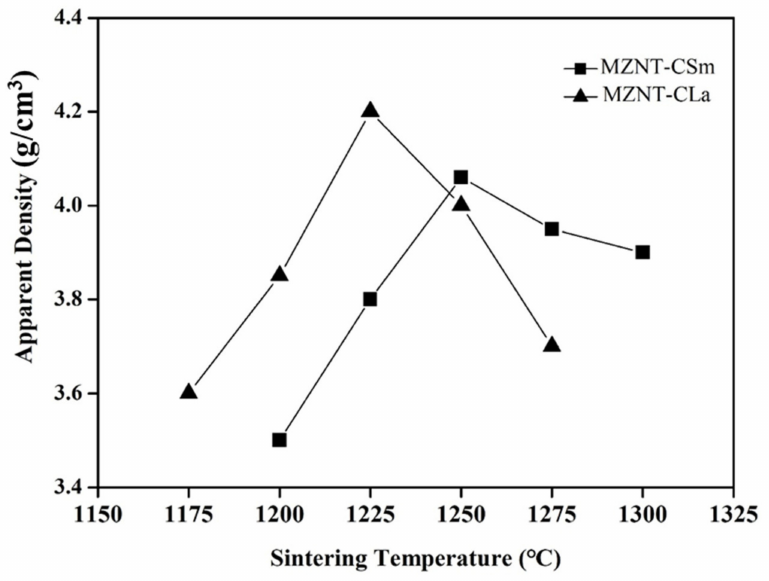
Figure 6. Dependence of apparent density on sintering temperature of the 0.88(Mg 0.6 Zn 0.4 ) 0.95 Ni 0.05 TiO 3 -0.12Ca 0.6 La 0.8/3 TiO 3 /Ca 0.8 Sm 0.4/3 TiO 3 ceramics. Table 1. Microwave dielectric properties of (Mg 0.6 Zn 0.4 ) 0.95 Ni 0.05 TiO 3 with Ca 0.6 La 0.8/3 TiO 3 sintered at 1225 ◦ C, and Ca 0.8 Sm 0.4/3 TiO 3 sintered at 1250 ◦ C for 4